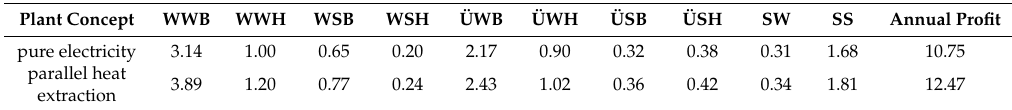
Table 5. Revenues for each typical day for pure electricity production and parallel heat extraction in million €